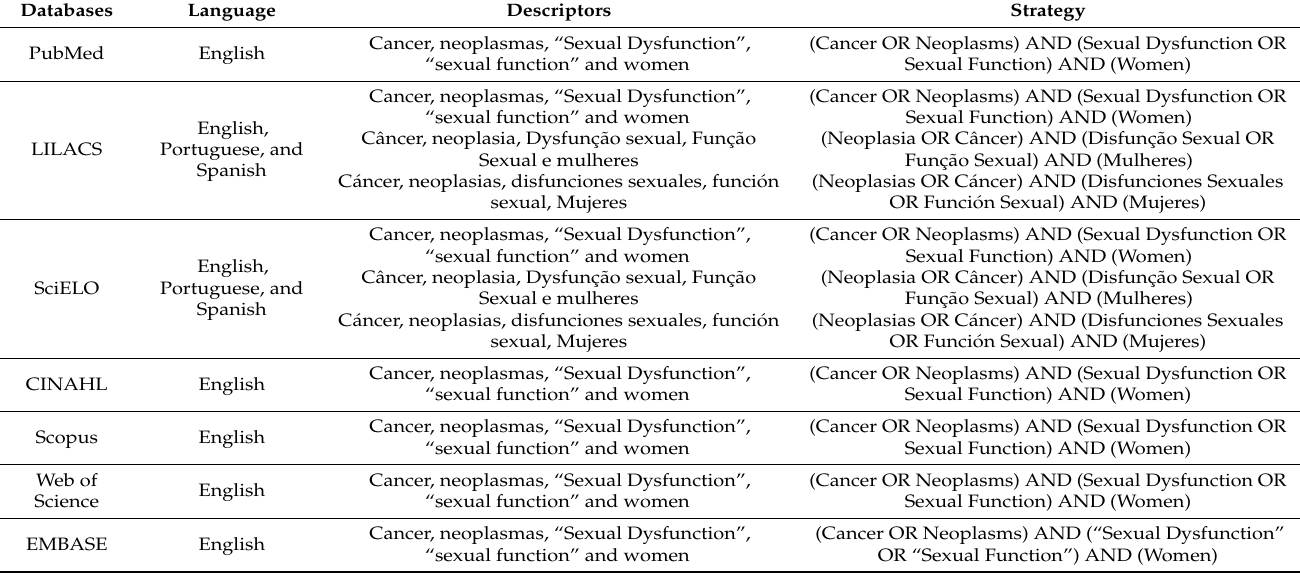
Table 1. Search strategy used in the systematic review. Source: